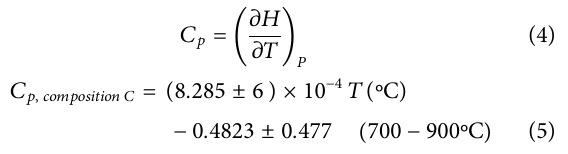
Frontiers in Physics |